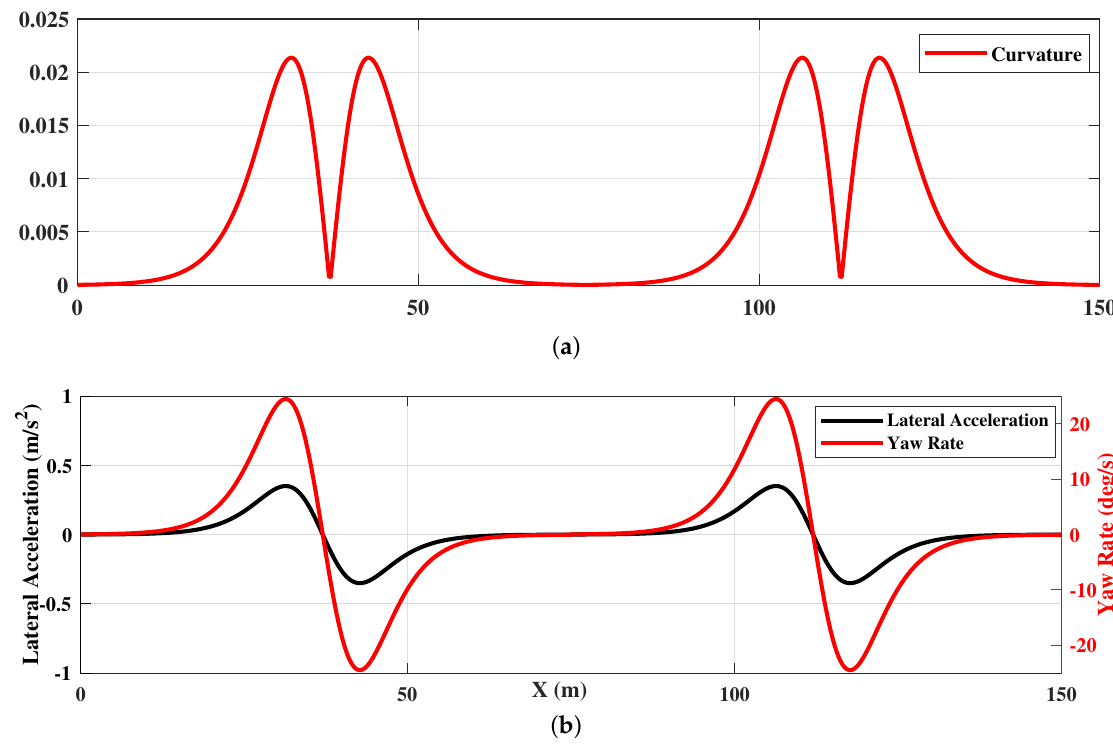
Figure 11. HPFSM path planning with constraints: ( a ) curvature of the planned trajectory; ( b ) yaw rate and lateral acceleration.